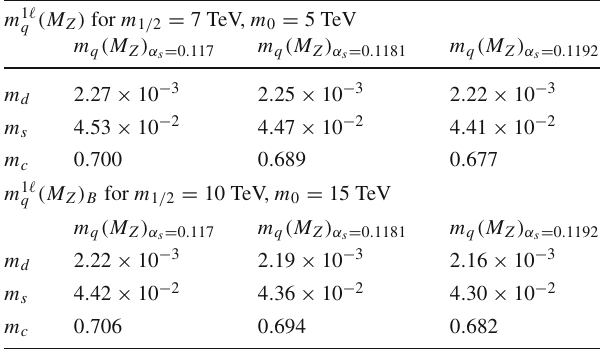
Table 5 One-loop-corrected quark masses (in GeV) at M Z